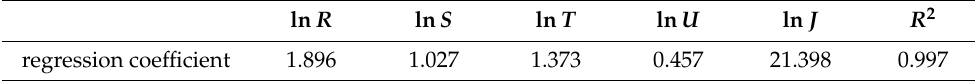
Table 9. Influencing factor coefficient of building carbon